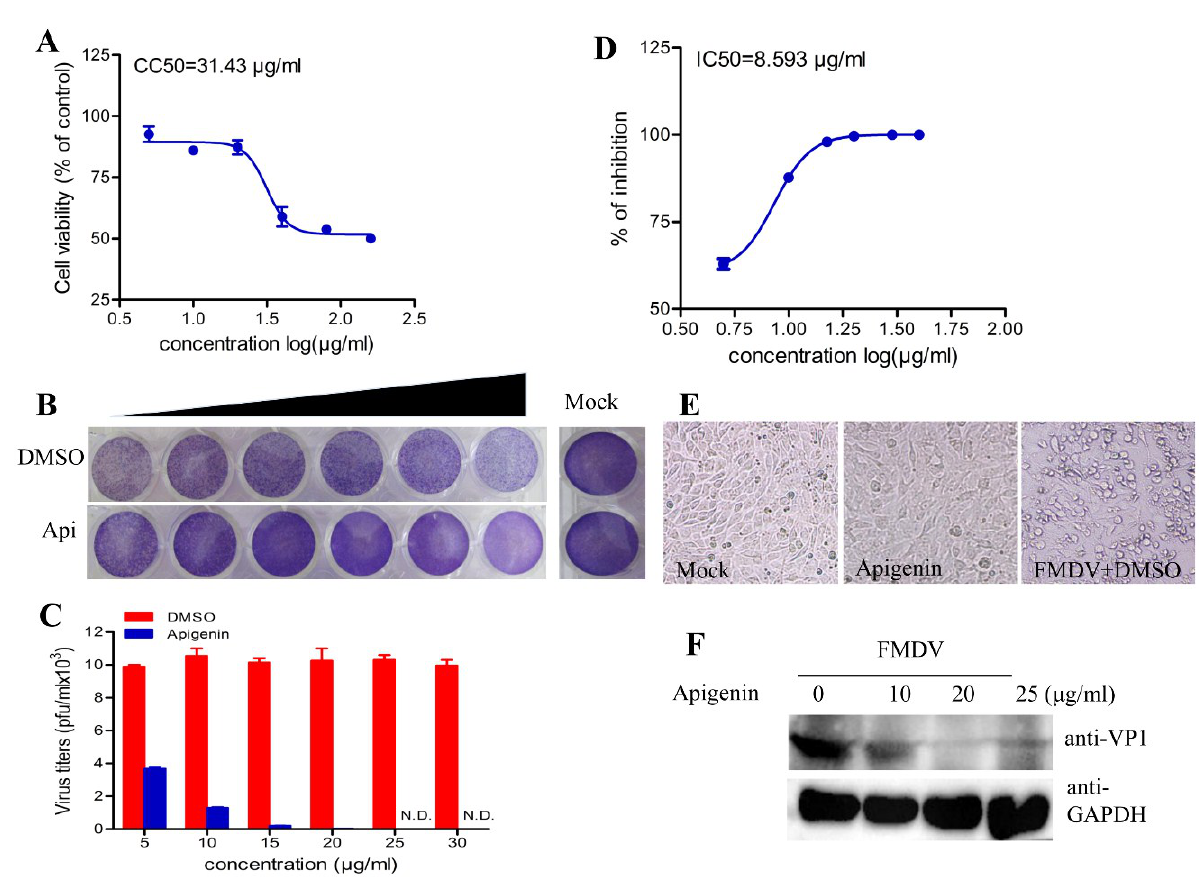
Figure 1. Apigenin-induced inhibition of FMDV infection. ( A ) Cytotoxicity of apigenin in BHK-21 cells. BHK-21 cells in 96-well plates were treated with apigenin at